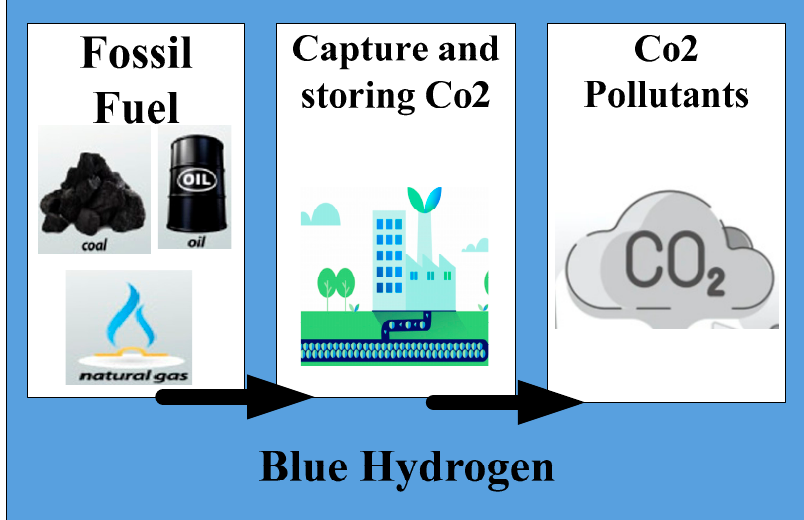
Figure 4. Schematic of Blue hydrogen production.